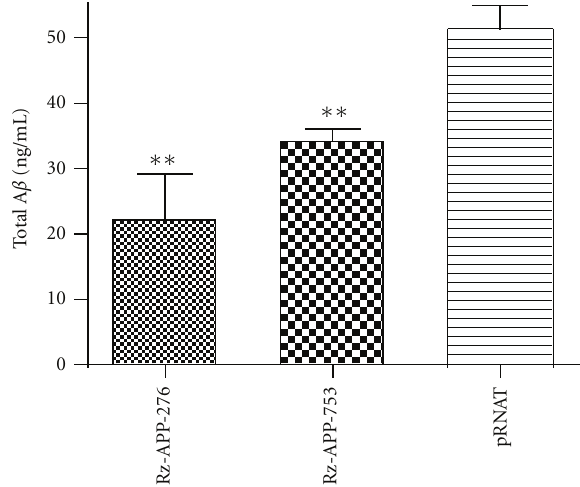
Figure 6: E ff ect of the most active ribozyme on the level of secreted total amyloid. The secreted levels of A β 1 − x were detected by sandwich ELISA, as described in Section 2. Media were collected following SH-SY5Y infection with the Rz-APP-286, Rz-APP-753, or pRNAT empty vector. The results are presented as the means ± SEM from 3 independent experiments. ∗∗ P < 0 . 001. Control cells were infected with the empty pRNAT vector